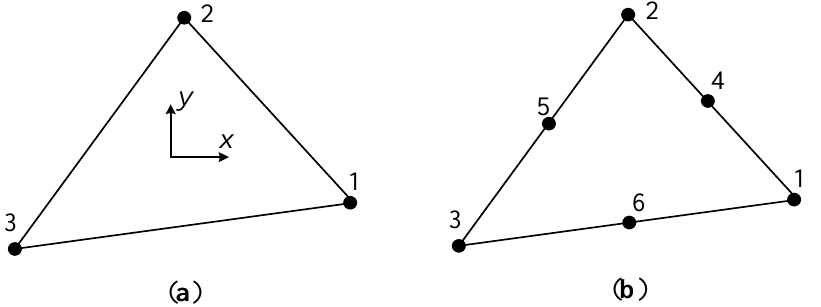
Figure 1. Triangular SDKT element: ( a ) Three-node element for the transverse displacement; ( b ) six-node element for the rotation.